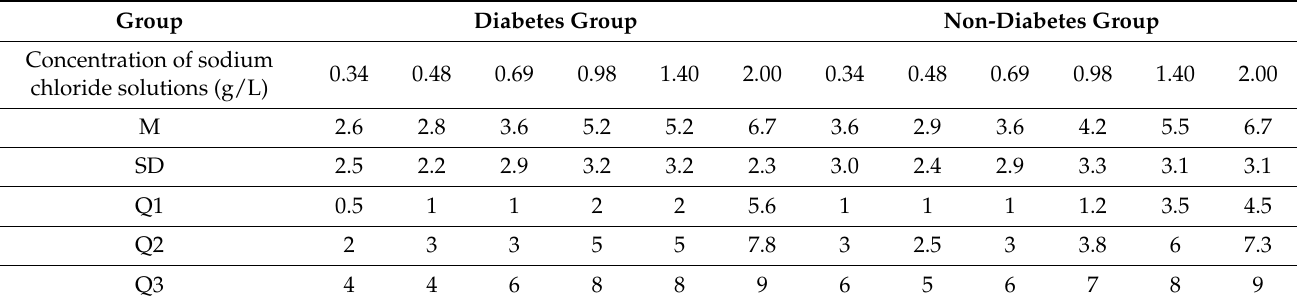
Table 7. Evaluation of the intensity of the perceived taste of sodium chloride solutions by group.